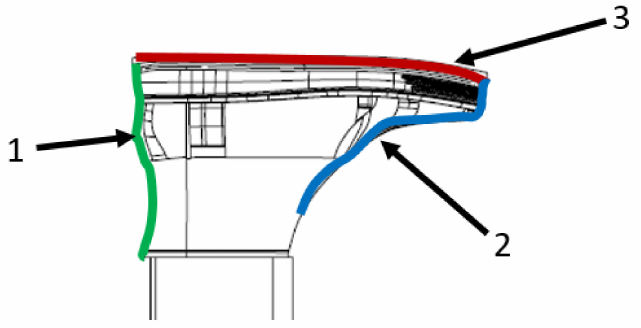
Figure 8. Scannable surfaces on the shoe.